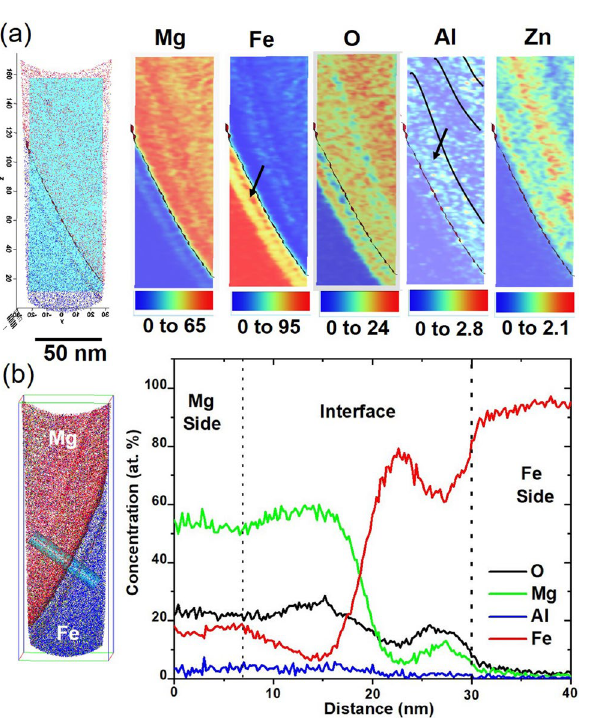
Figure 5. Elemental distribution across the interfacial region of the FaST joint between AZ31 and DP590. ( a ) Two-dimensional compositional map of the Fe, Mg, O, Al and Zn; ( b ) one-dimensional composition change along a cylinder 10 nm in diameter and 60 nm